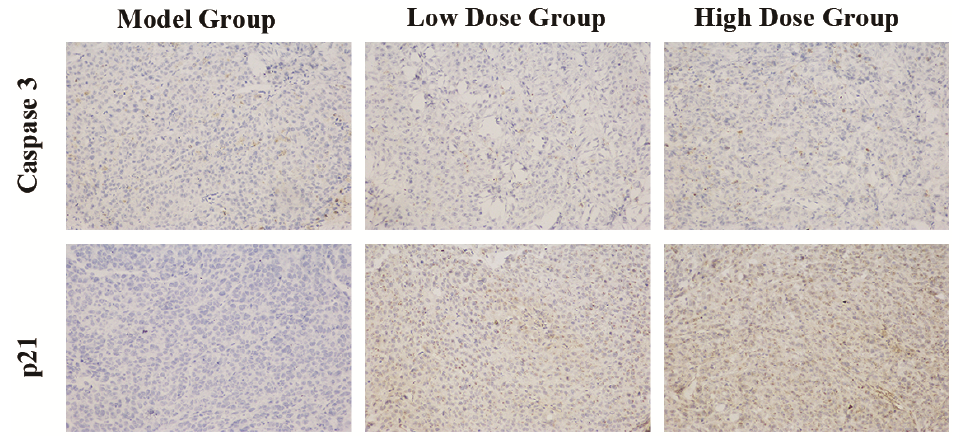
Figure 3. Caspase 3 and p21 immunochemical staining of tumor xenografts sections (200× magnification) ( n = 3).